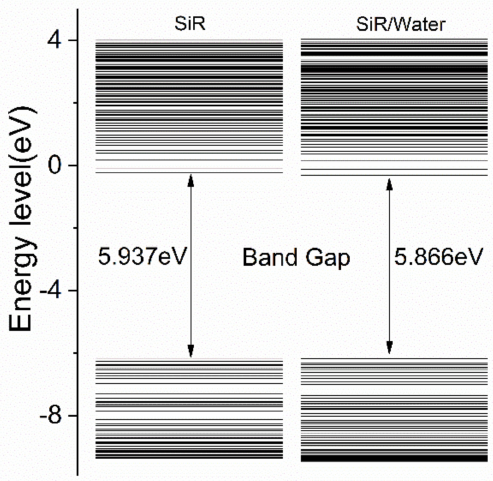
Figure 9. Electron Orbital distribution of SiR with